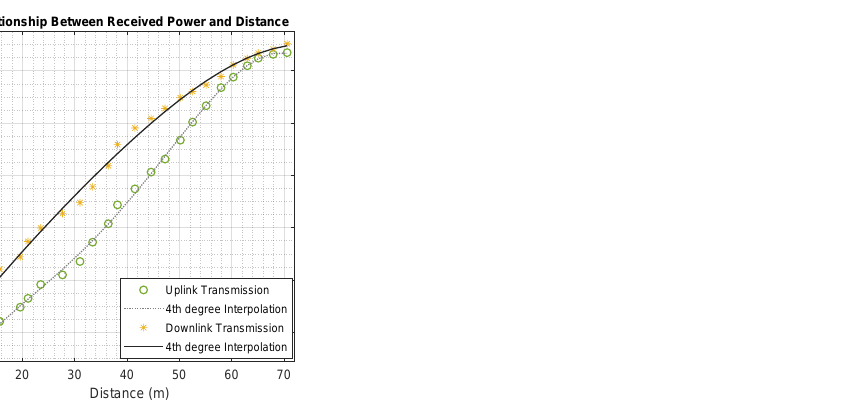
Figure 13. Uplink and Downlink Received Power and Dependency on NB-IoT Distances from the